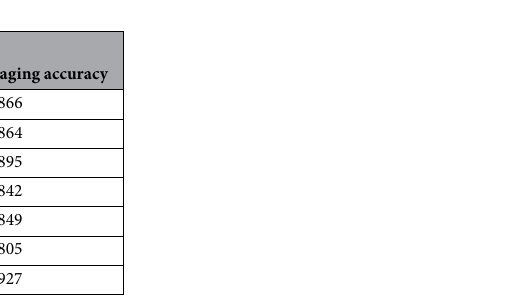
Staging accuracyAccuracy Sensitivity Specificity